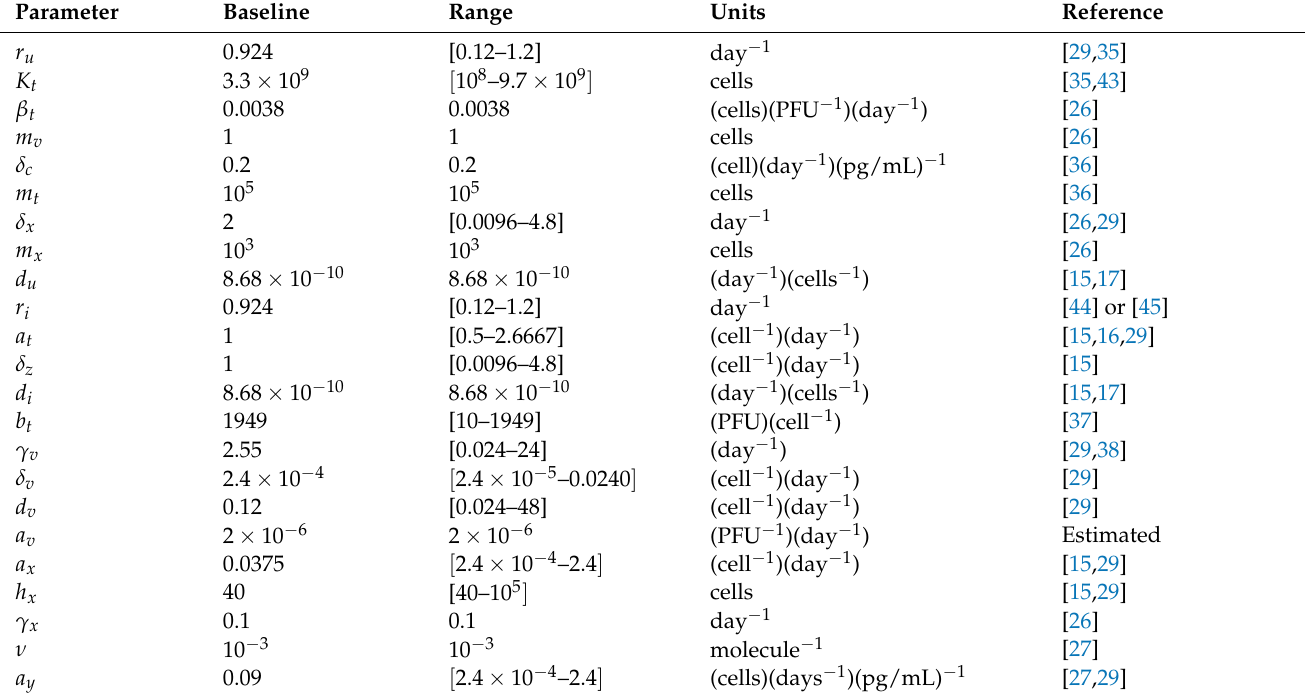
Table 3 summarizes model parameter values and value ranges, and values used in simulations. Table 3. Parameter baseline